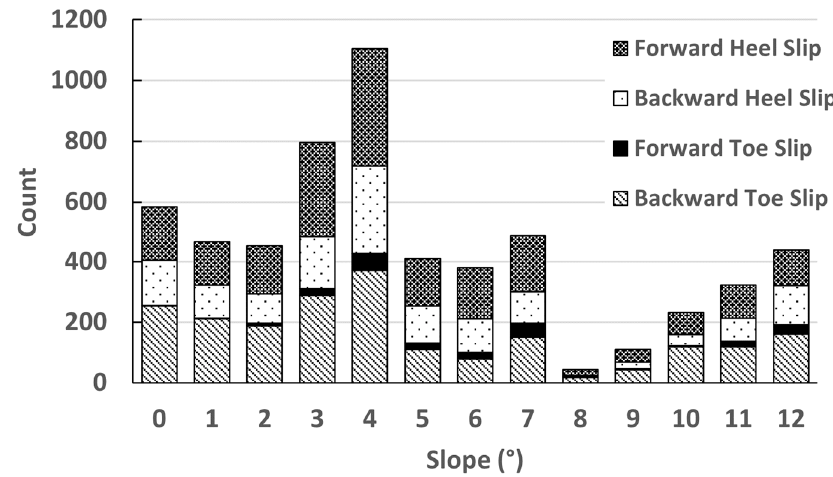
Figure 9. The distribution of different slips recorded across different slopes.